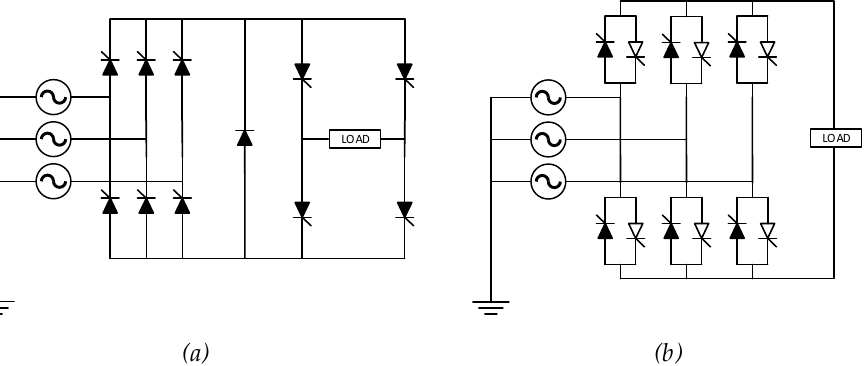
Figure 3. Qualitative schemes of the AC to DC converter. ( a ) The configuration with a three-phase full-wave controller bridge and H bridge. ( b ) The configuration with a double antiparallel three-phase full-wave controller bridge.